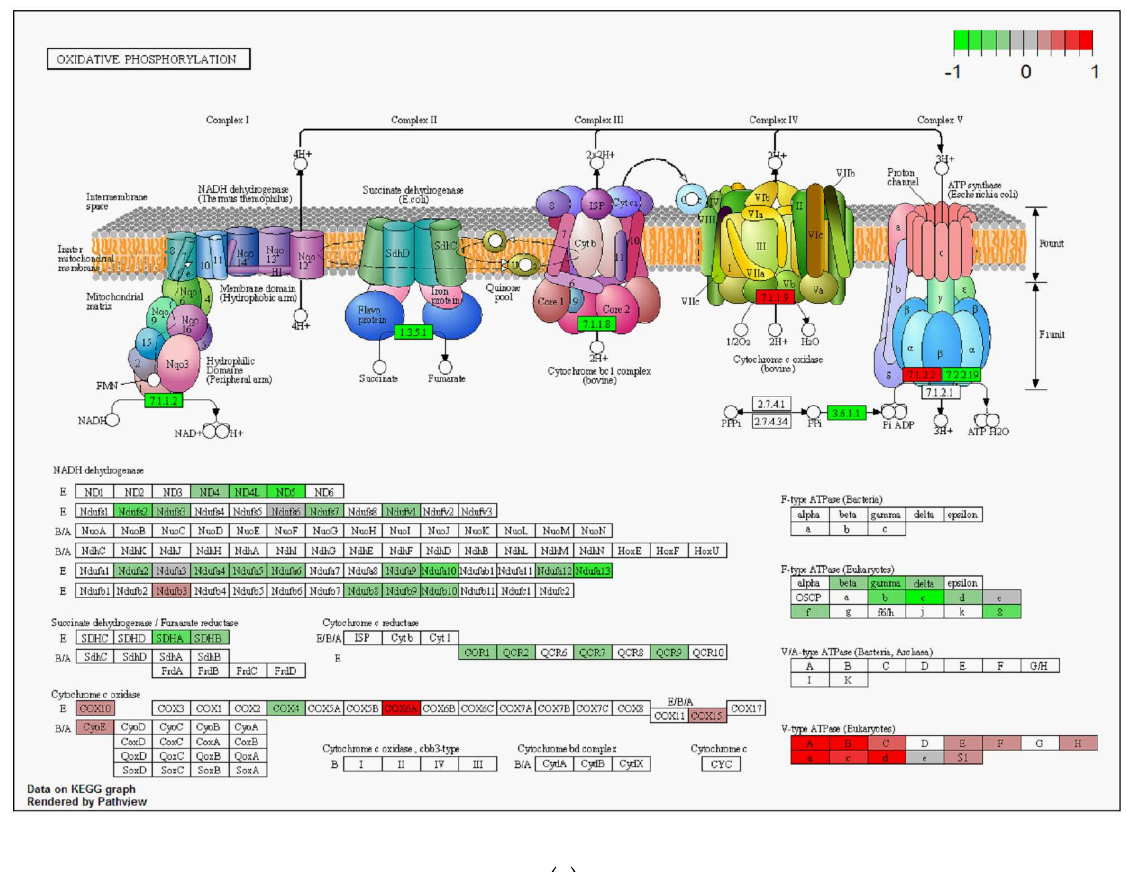
Figure 5. Regulation of genes related to glycolysis/neoglucogenesis ( a ), branched chain amino acid metabolism ( b ) and mitochondria ( c ) in HFoleic group compared to reference group. Down- and Up-regulations of transcript levels in VAT are represented in green and red, respectively. Regulations were mapped using Pathview (R-Bioconductor) and KEGG database.